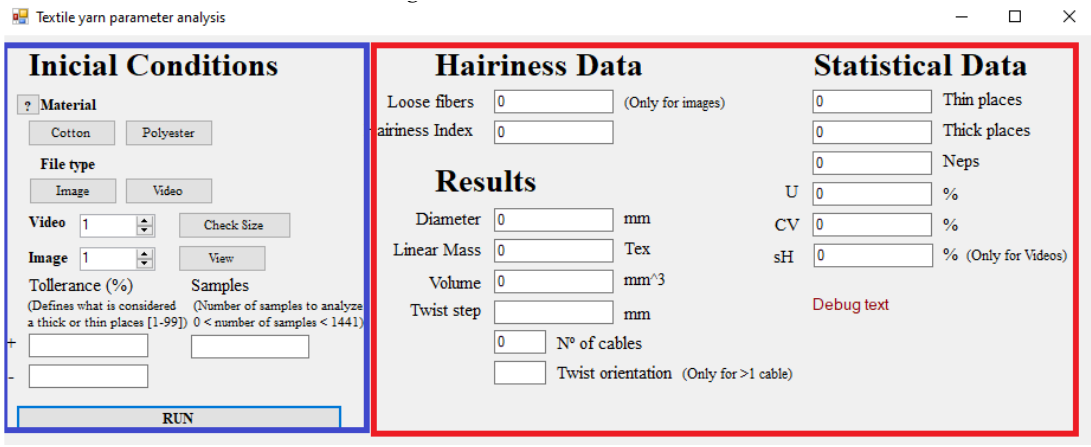
Figure 33. User interface.